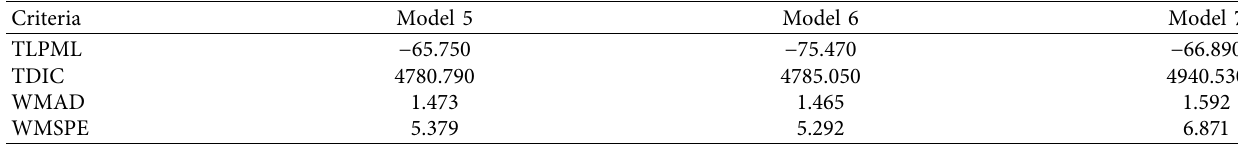
Table 5: Summarized results of the predictive performance for models 5–7.